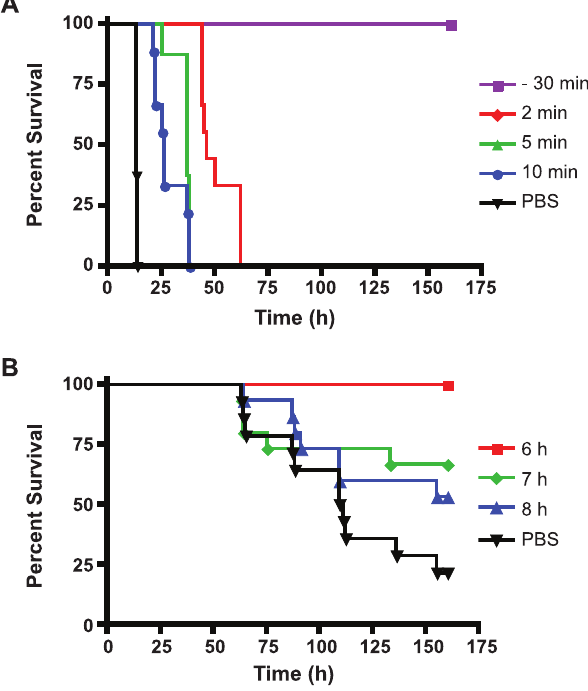
Figure 4. Neutralization of ricin with polyclonal ricin antibod- ies. Survival percentage of mice dosed iv (A) or ig (B) with ricin were plotted over 160 h post-intoxication. Goat anti-ricin antibodies were introduced iv either prior-to or post-intoxication at indicated times. PBS was injected into mice as no treatment control. Comparison of survival curves with log rank test yielded statistical significance of p , 0.001 and p , 0.0144 for A and B respectively.